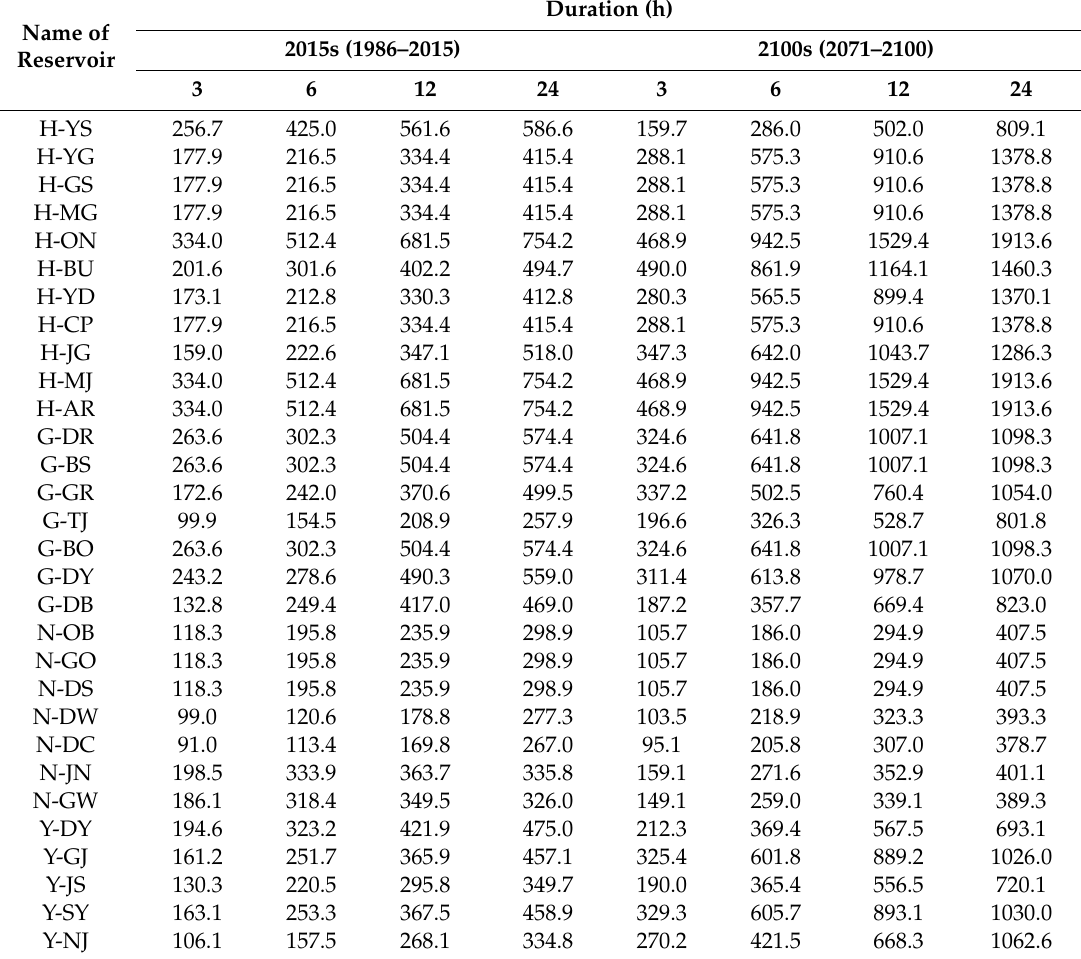
Table 2. Probable rainfall (mm) for four durations (3, 6, 12, and 24-h) and a 200-y return period